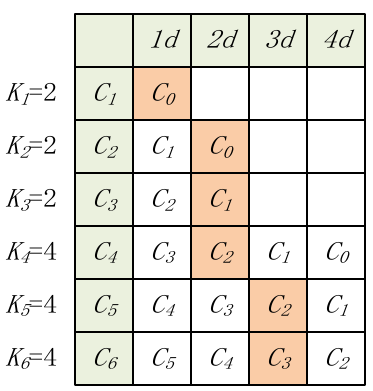
Figure 5. Corona